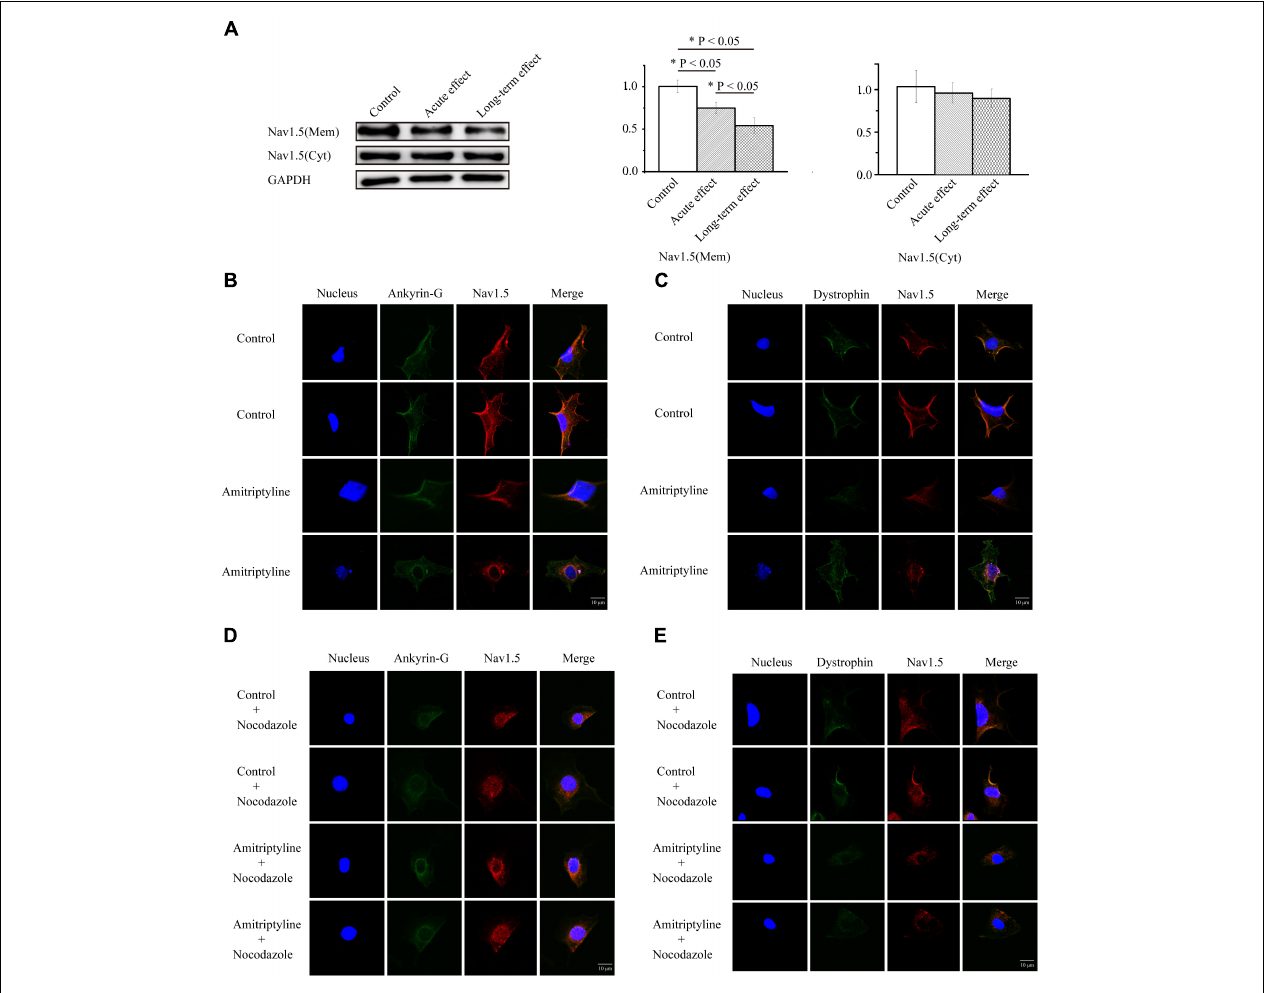
FIGURE 4 | Long-term effect of amitriptyline on protein expression and distribution of Nav1.5. (A) Protein expression of Nav1.5 in control cells, cells with acute treatments of amitriptyline and cells with long-term treatments with amitriptyline. (B) Representative confocal images of Nav1.5 (red) and ankyrin-G (green) without or with long-term treatments with amitriptyline. (C) Representative confocal images of Nav1.5 (red) and dystrophin (green) without or with long-term treatments with amitriptyline. (D) Representative confocal images of Nav1.5 and ankyrin-G with nocodazole treatments. (E) Representative confocal images of Nav1.5 and dystrophin with nocodazole treatments. The blue signal indicates the nucleus. Scale bar: 10 µ m. ∗ P <